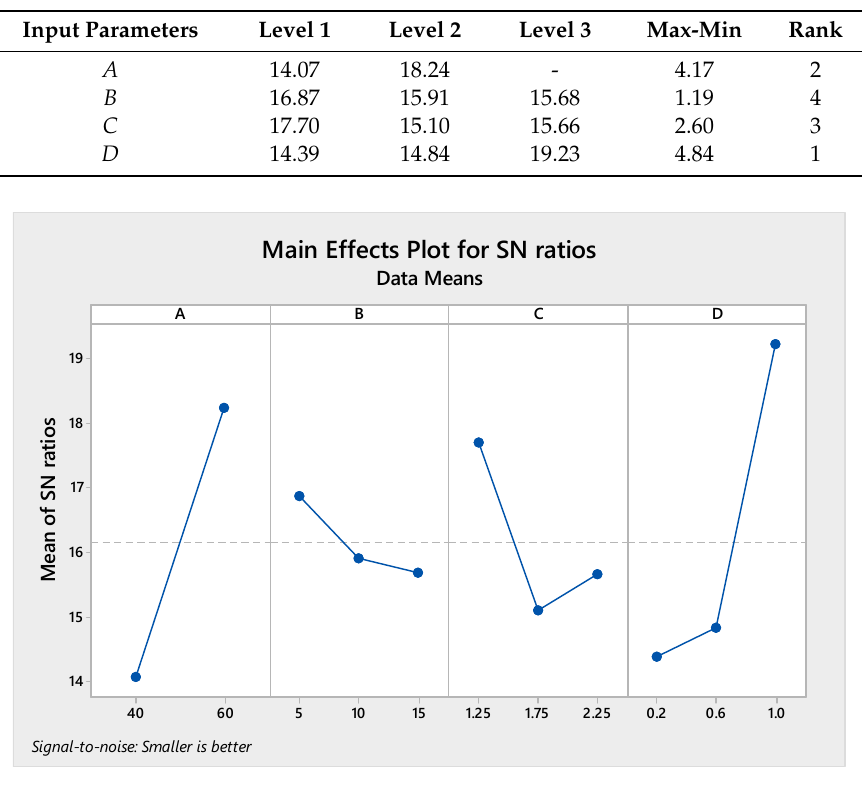
Figure 4. S/N graph. Figure 4. S / N